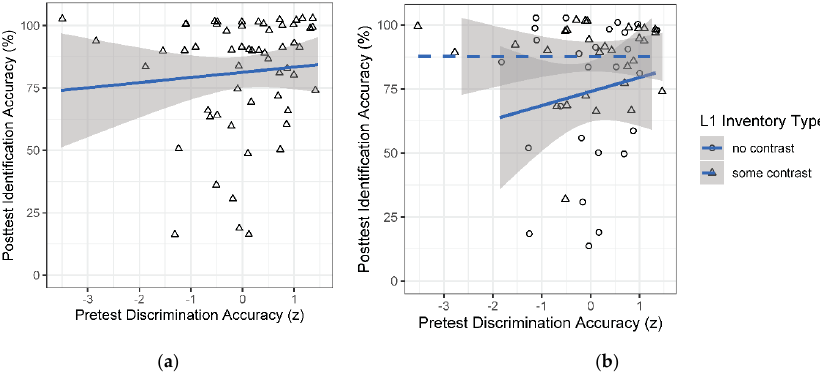
Figure 10. Individual posttest accuracy in the vowel study by pretest performance, with regression lines ( a ) over all L1 groups together, and ( b ) over each L1 group separately. Points are jittered; the shaded areas indicate the 95% confidence interval around the regression line.